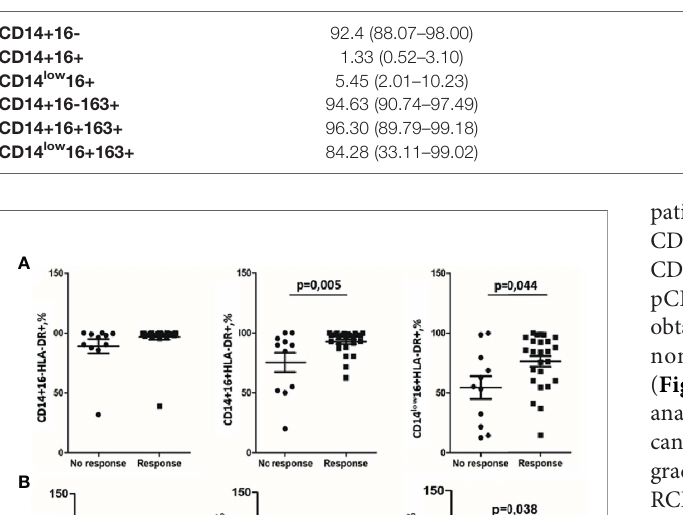
TABLE 2 | Flow cytometry analysis of CD14, CD16, and CD163 markers on monocytes from BC patients depending on clinical response to NAC. Subset BC without response, %, Median (Q1 – Q3) BC with response,%, Median (Q1 –